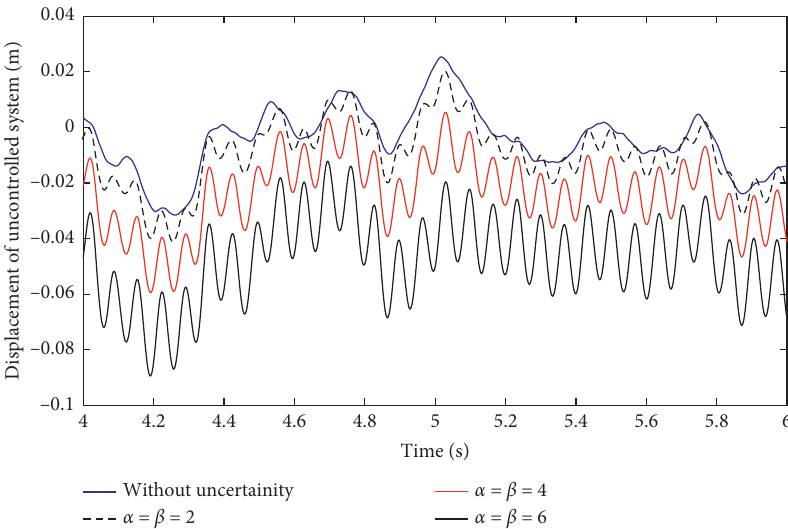
Figure 13: Uncontrolled system behavior in the presence of system uncertainties (detailed view). Table 6: Maximum displacement for various amounts of α and β